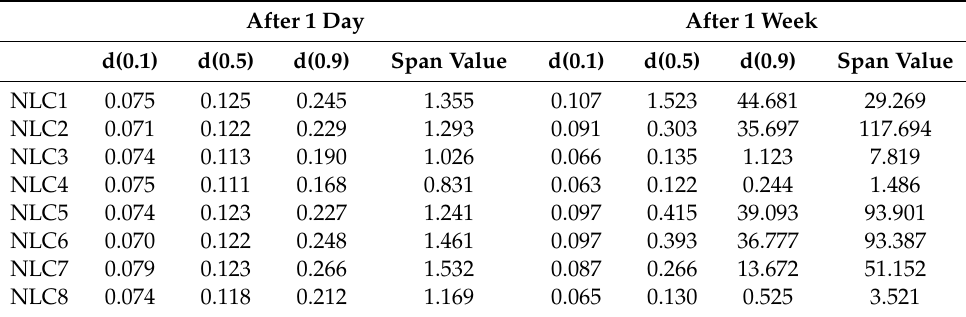
Table 3. The results of laser di ff raction-based particle size analysis. After 1 Day After 1